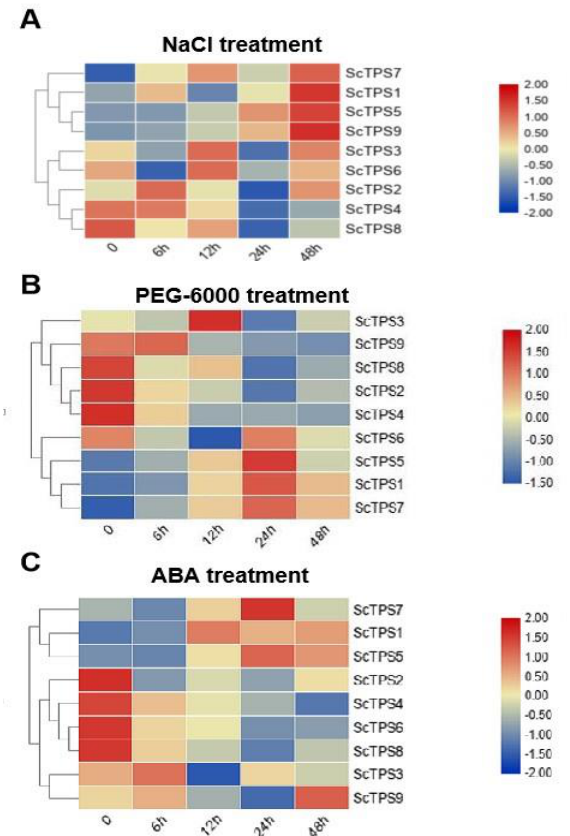
Figure 6. Expression pattern of ScTPS genes upon NaCl ( A ), PEG-6000 ( B ) and ABA ( C ) treatments. The stress conditions are salt (200 mM NaCl), 10% (w / v) PEG-6000 treatment and ABA treatment (30 nM). Control samples (setting of zero) are collected before treatment, and were compared with the test samples at 6, 12, 24 and 48 h post-treatment. Color scale represents fold changes (Treatment / Control) normalized log2 transformed data. Red indicates up-regulated and blue indicates down-regulated genes.